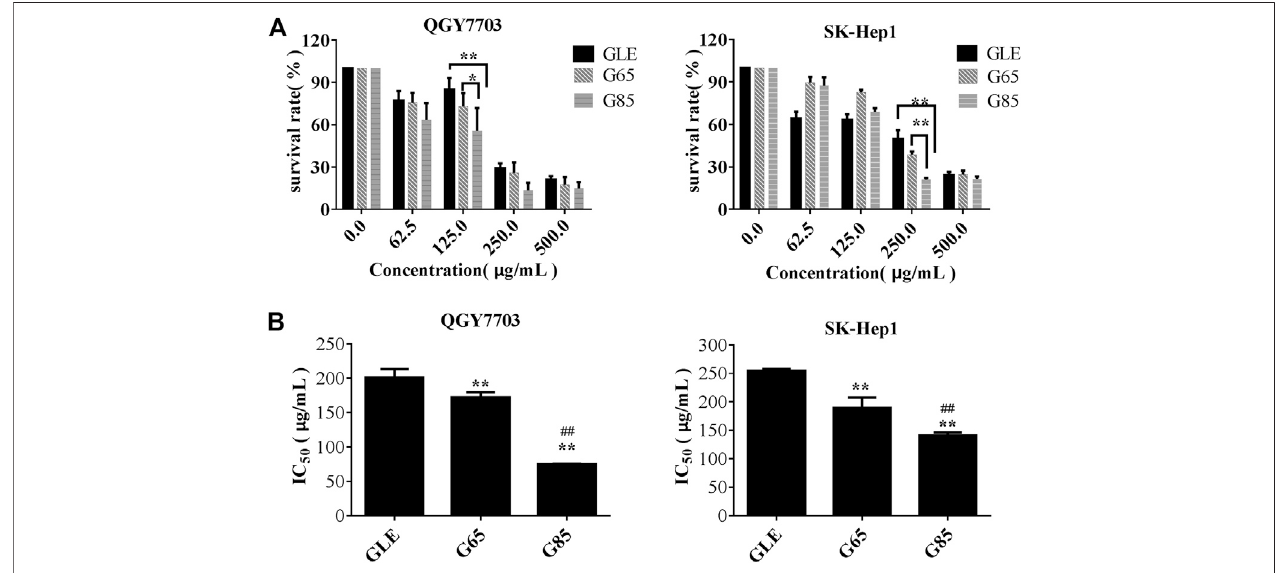
FIGURE 2 | The cytotoxicity of G. lucidum extracts on human hepatoma carcinoma. (A) QGY7703, SK-Hep1 cells were treated with GLE, G65, and G85 for 72 h and cell viability measured by MTT and expressed as a percentage of vehicle control. (B) The IC 50 value of G. lucidum extracts on QGY7703, SK-Hep1 cells after exposure of 72 h ( n (cid:2) 3). Data were shown as mean ± SD ( n (cid:2) 3), ** p < 0.01 vs GLE, ## p < 0.01 vs G65.